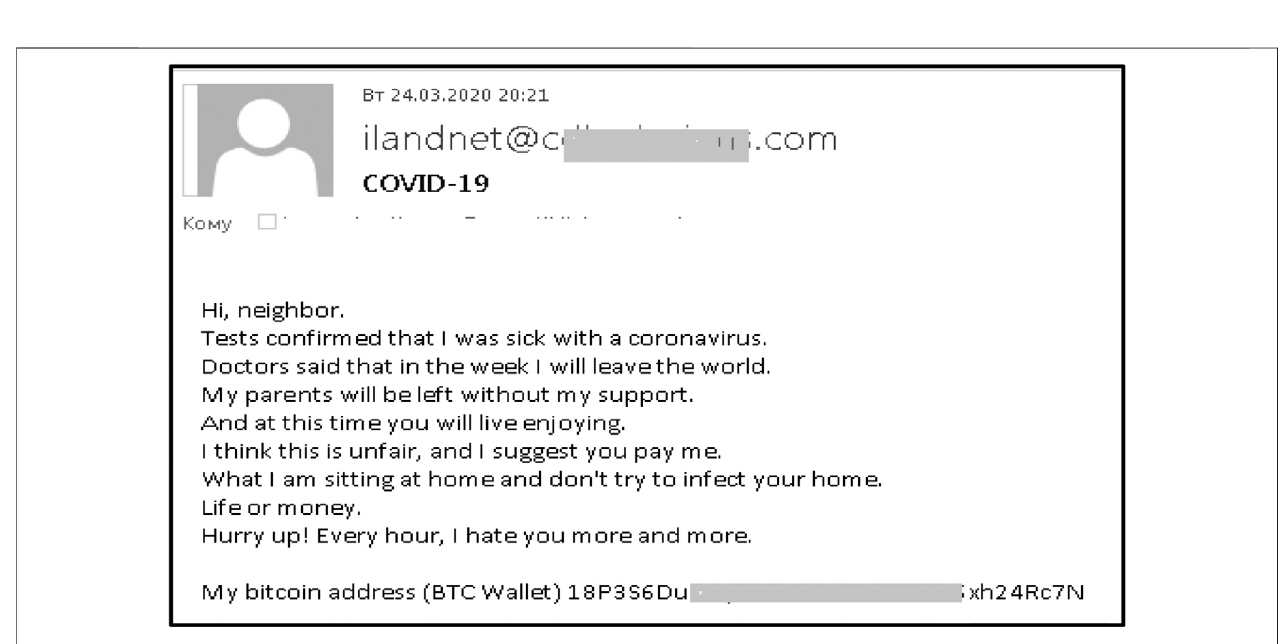
FIGURE 3 | Screenshot of a coronavirus related phishing email (Ksepersky,